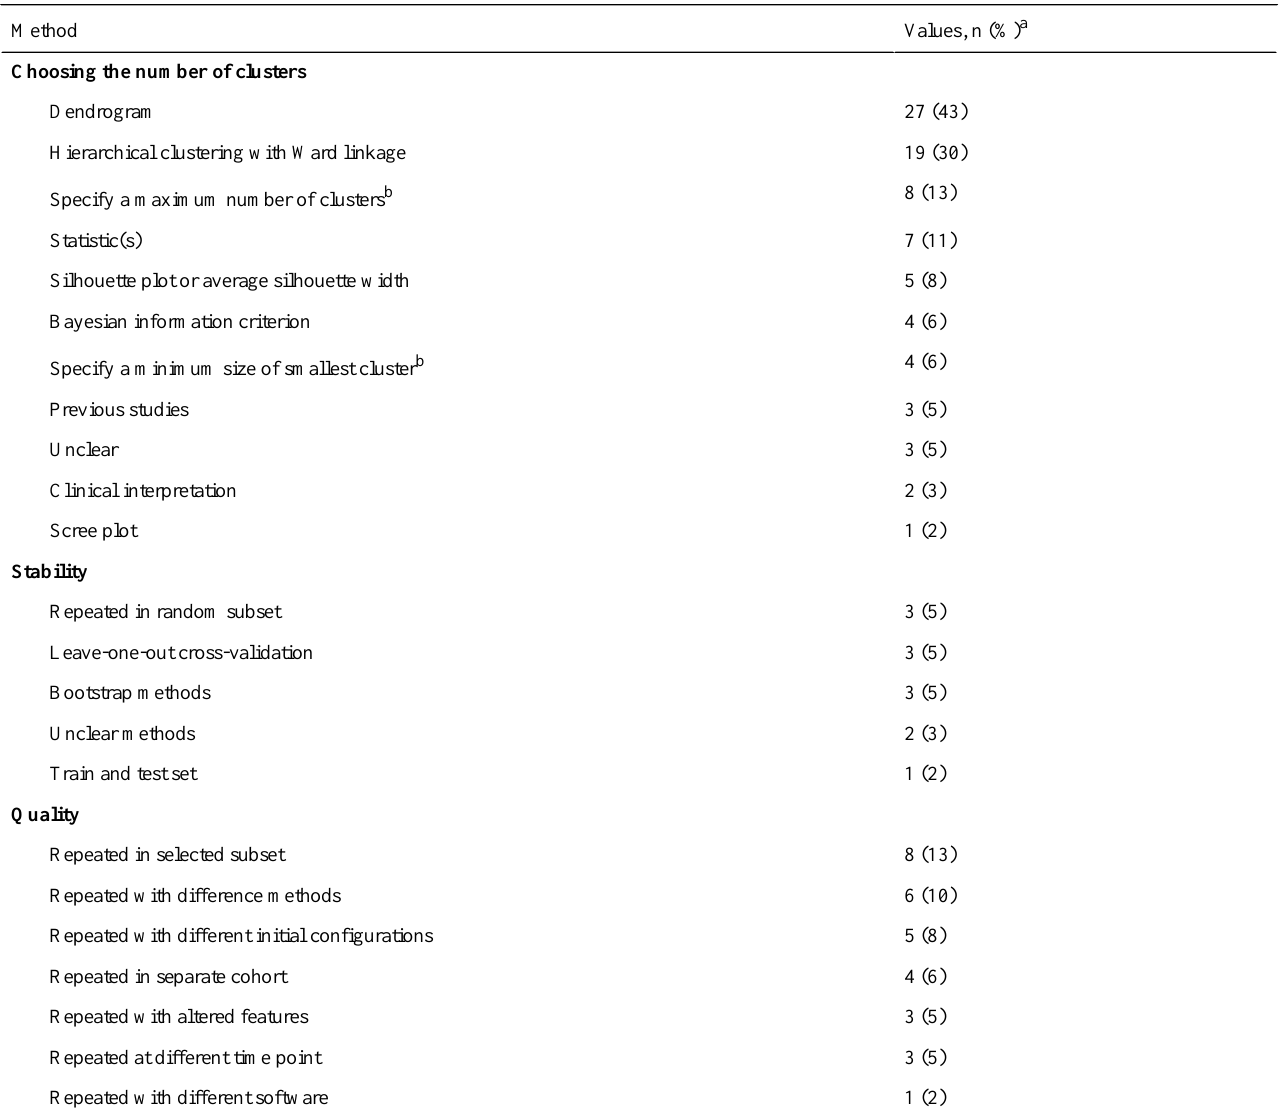
Table 6. Postprocessing methods used in the asthma studies included in this